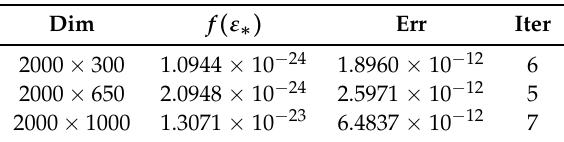
Table 1. Computational results from recovering three matrices of different dimensions and 30% of known entries. The rank is fixed to be